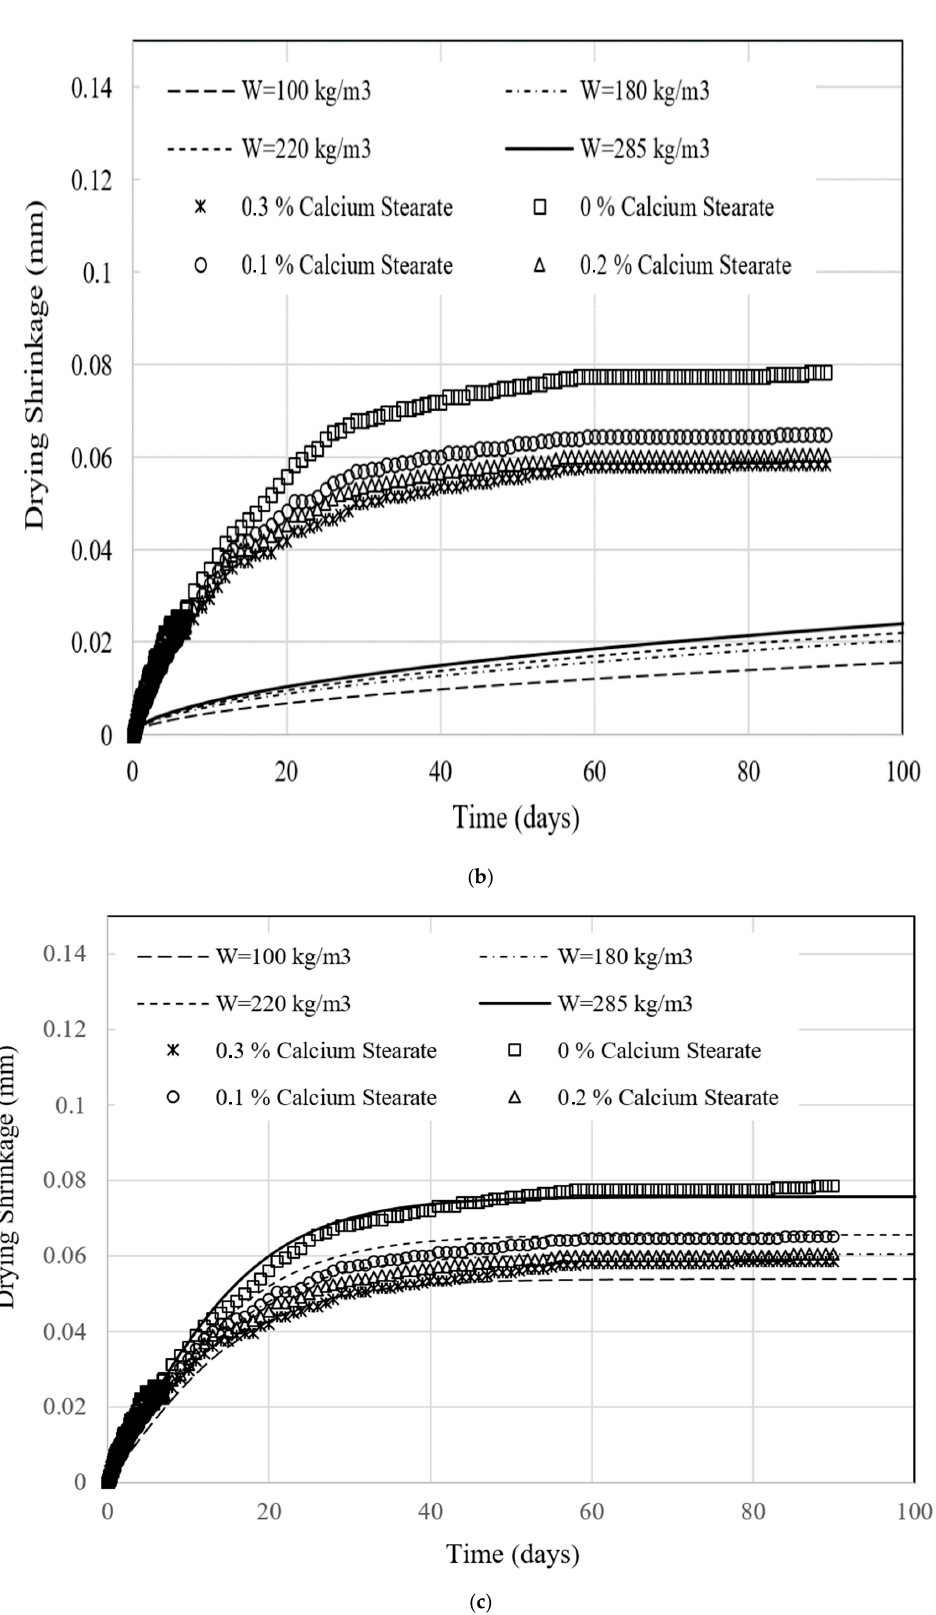
Figure 7. Comparison between the shrinkage model, i.e., ( a ) the Sakata [23], ( b ) the Japan Standards [24] and ( c ) the Bazant–Baweja [25] models with water content variations and the experiment with di ff erent fractions of calcium